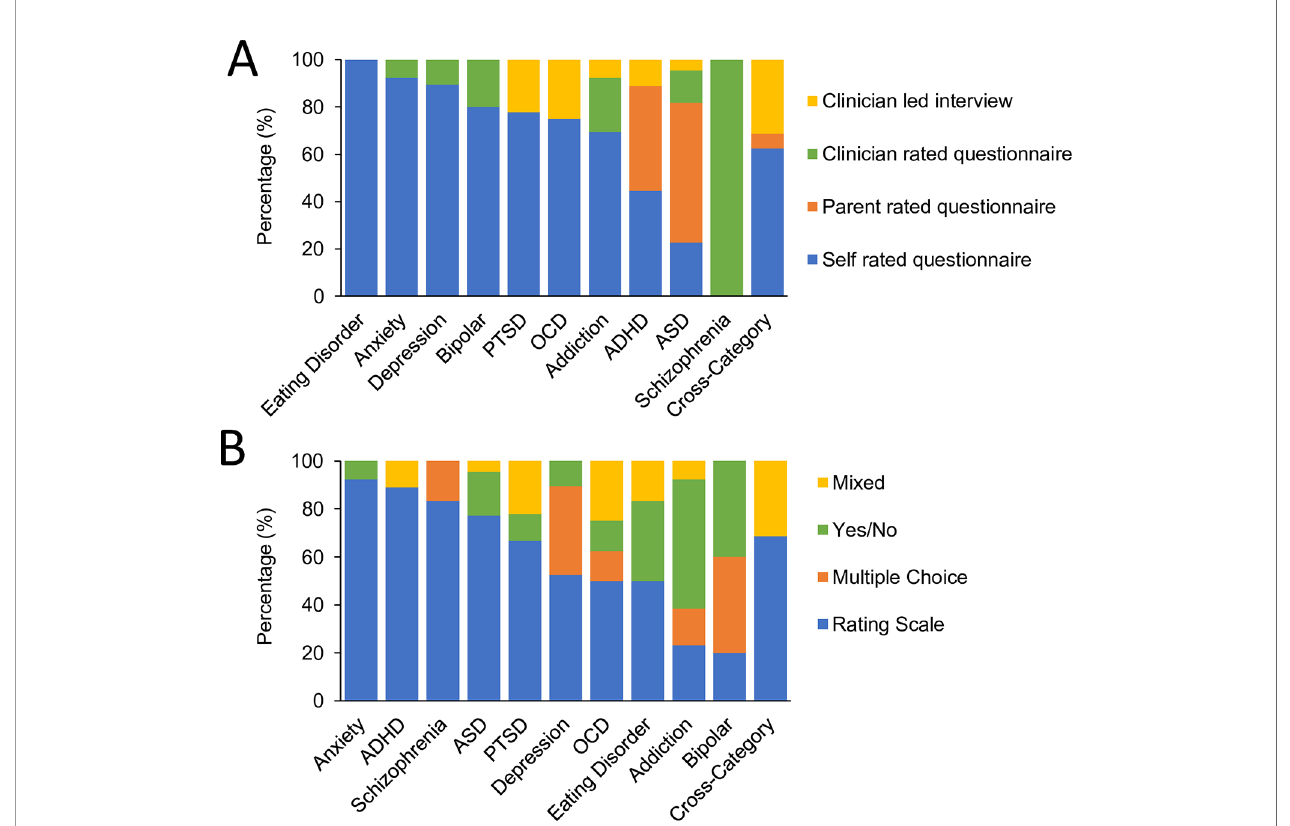
FIGURE 1 | Format of assessment tools. (A) Comparative proportion of assessment tools by format of administration; self rated questionnaires (blue), parent rated questionnaires (orange), clinician rated questionnaires (green), or clinician led interviews (yellow). (B) Comparative proportion of assessment tools by format of questions; rating scale (blue) a multiple choice list (orange), a yes/no response (green) or a mix of response options